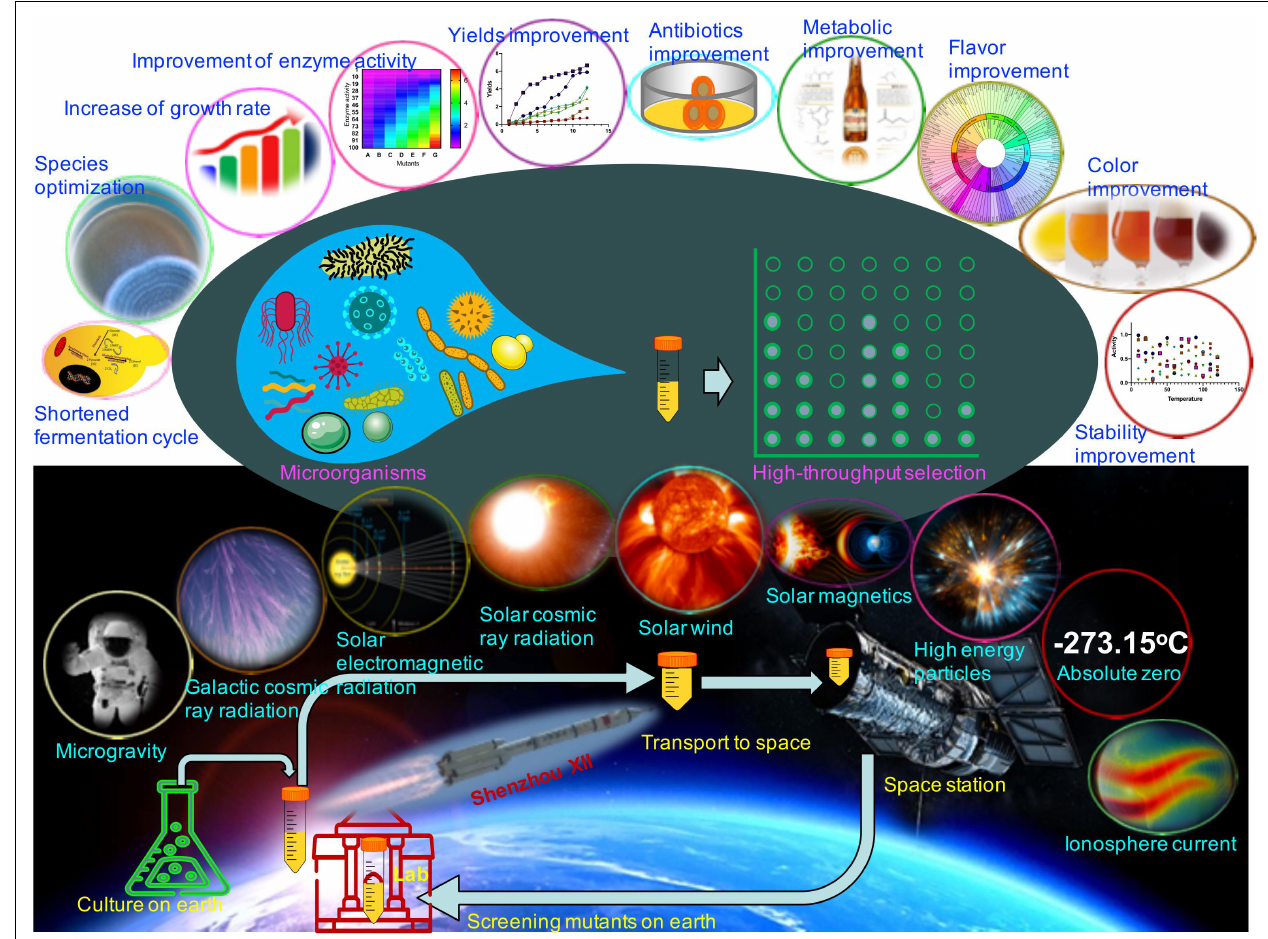
FIGURE 1 | Possible effects of the space’s extreme environment on the fermentation potential of microorganisms. The space’s environment mainly includes microgravity, space radiation (galactic cosmic ray, electromagnetic waves, solar cosmic ray, solar wind, and solar magnetic and/or high energetic particles), ionosphere current, and a degree above absolute zero. Most microorganism mutants may be induced with the improvement of fermentation potentials via the space’s extreme environment, including species, growth rate, enzyme activities, product yields, antibiotic activities, metabolite composition, fermentation flavor and color, and strain stability ( Supplementary Table 1